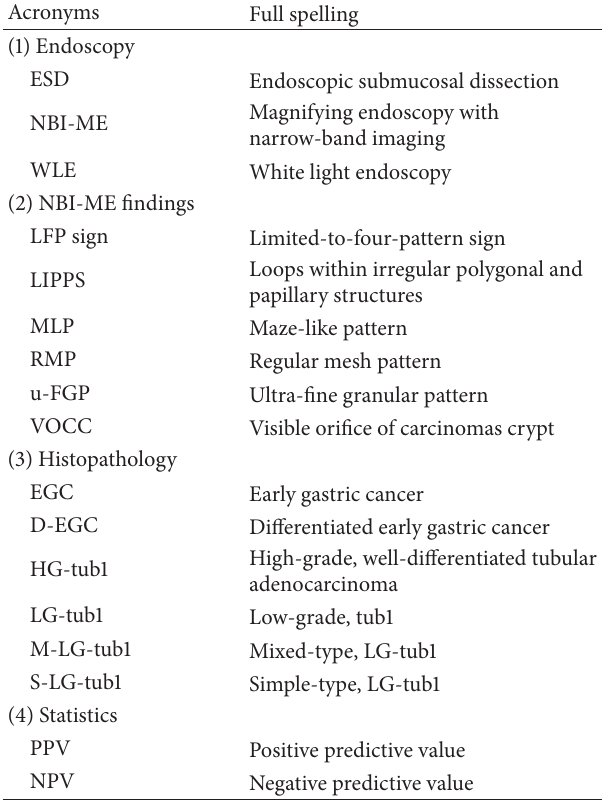
Table 1: List of acronyms by